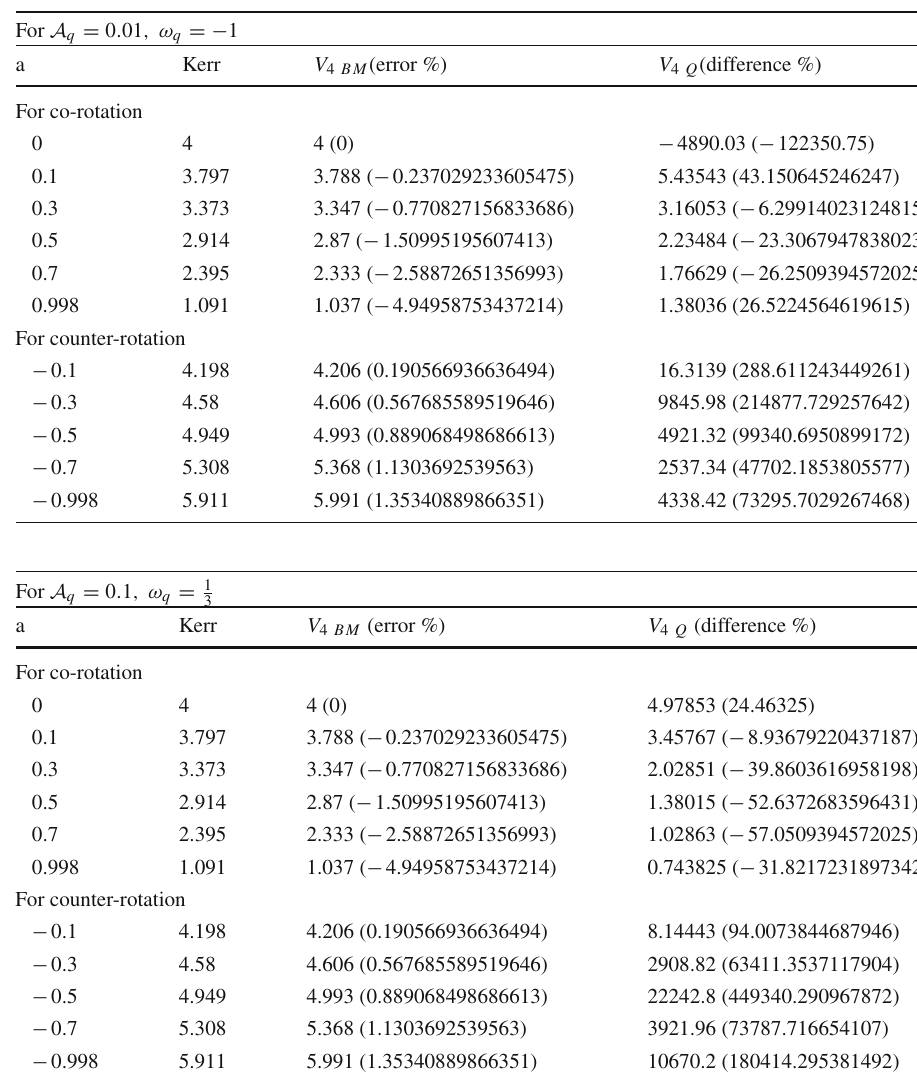
For A q = 0 . 01 , ω q = − 1